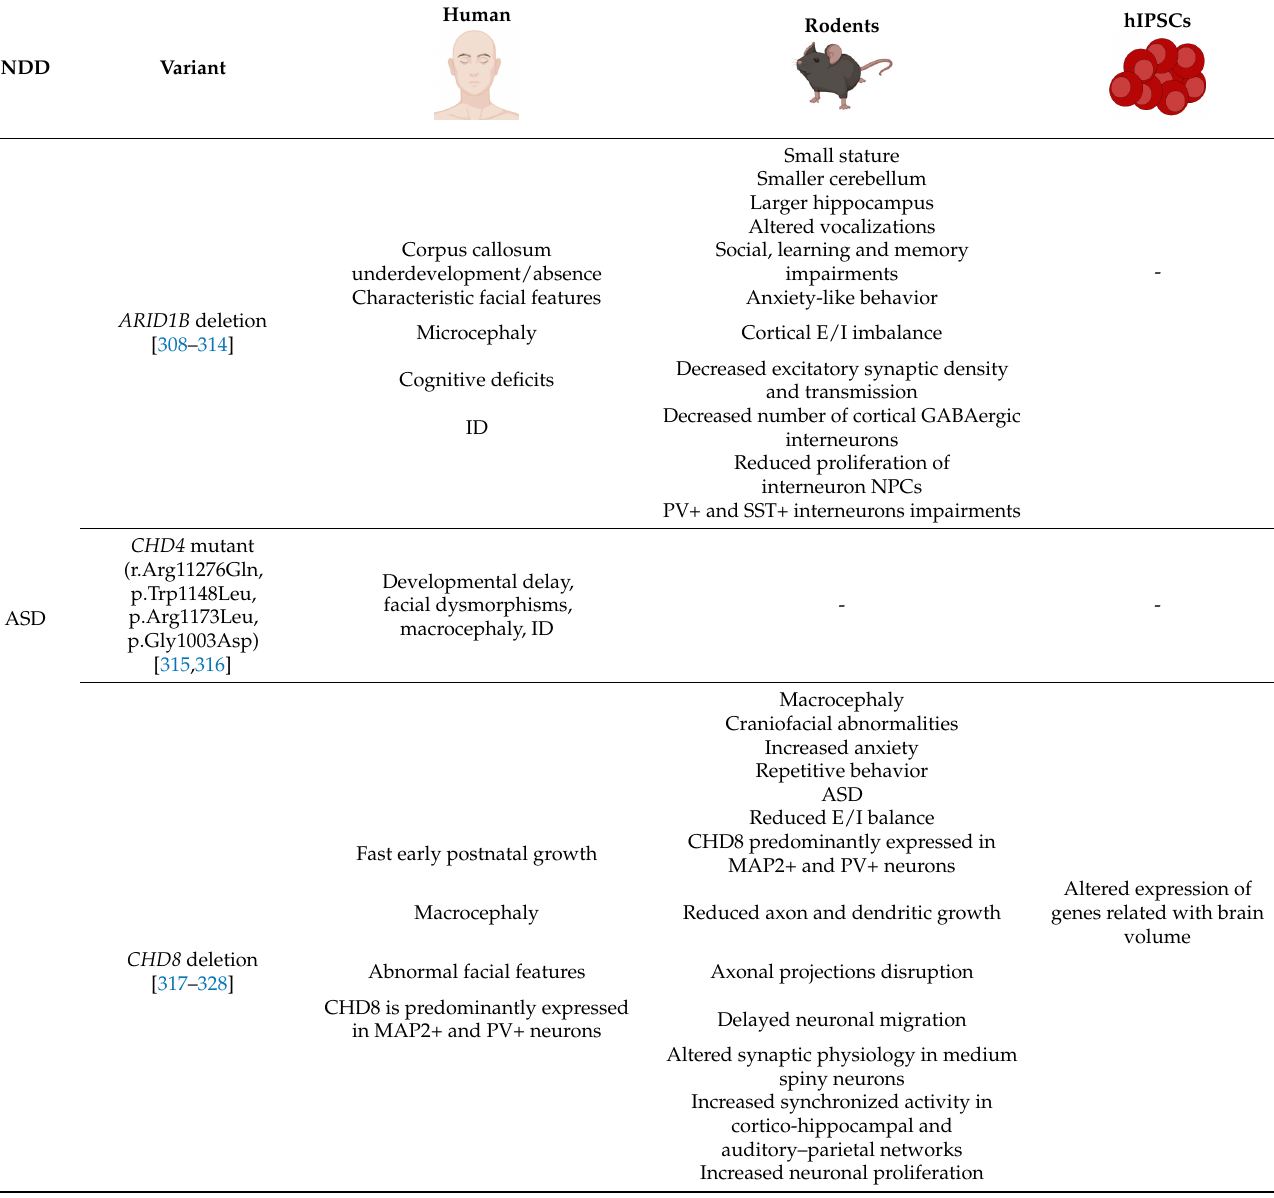
Table 3. Described ASD human, rodent and hIPSCs phenotypes.